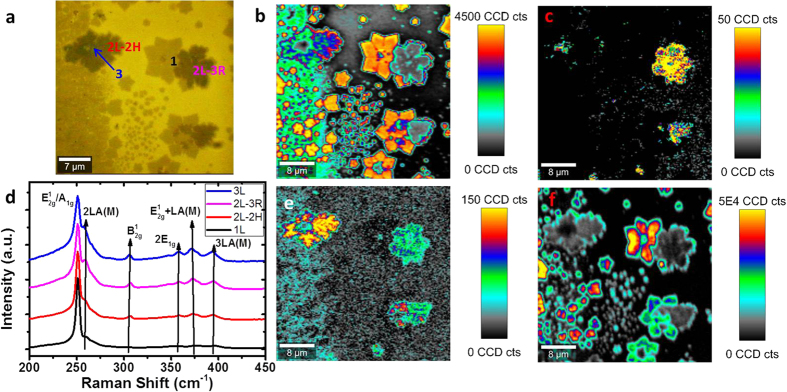
(a) Optical image of CVD WSe2 with varying layer numbers. (b) Peak intensity map of A’1/A1g and E’/Eg/E12g overlapping modes (~250 cm−1). (c) Peak intensity map of 2LA(M) peak (~260 cm−1). (d) Raman spectra of 1L, 2L-2H, 2L-3R and 3L-2H WSe2. (e) Peak intensity map of A’1/A1g/B2g (~310 cm−1) Raman mode. (f) PL intensity map.